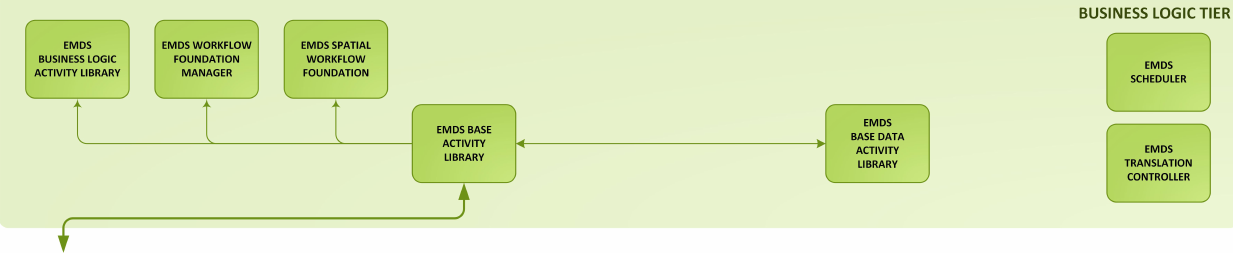
Figure 4. Business Logic Tier. The Business Logic Tier exposes a series of REST Services and Workflow Activity libraries that allow applications to easily tap into the power of the engines and